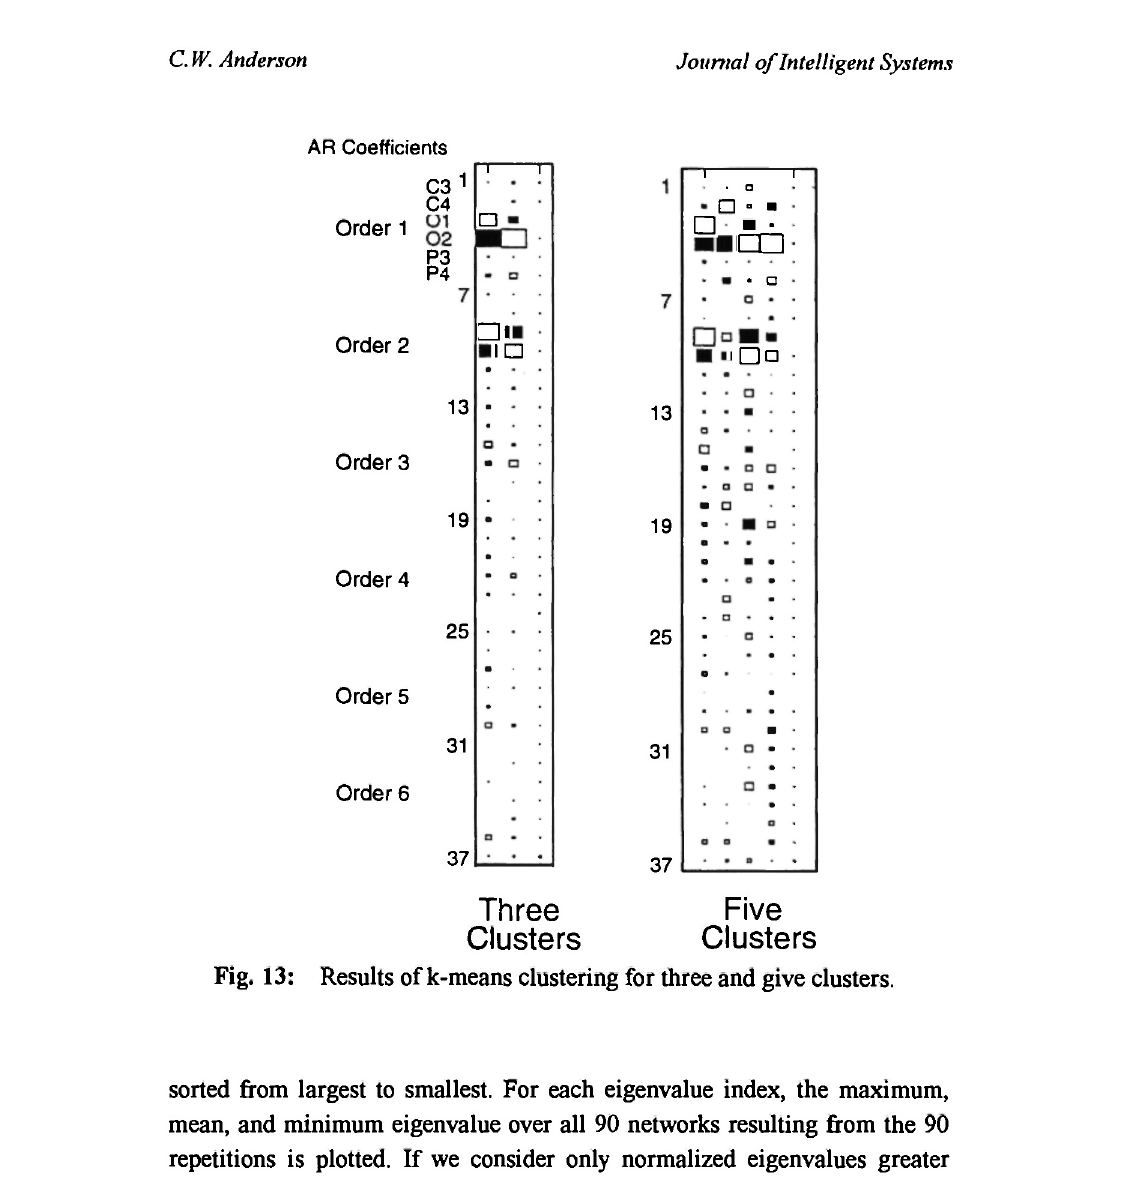
Fig. 13: Results of k-means clustering for three and give